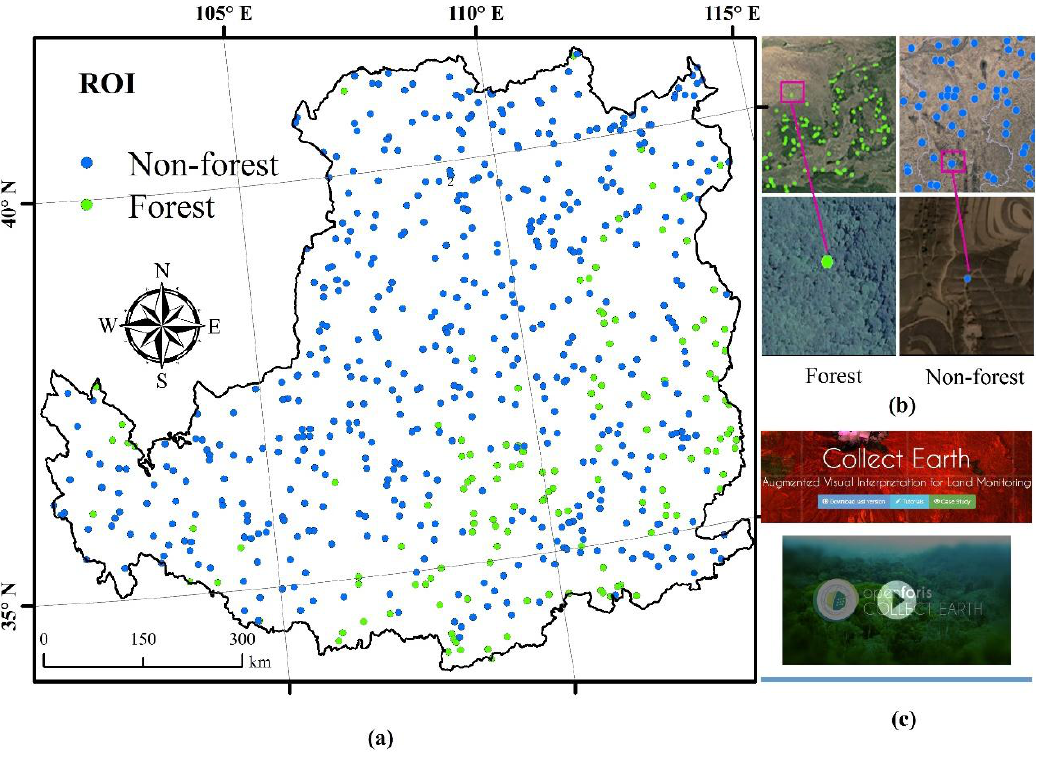
Figure 5. Spatial distribution of the randomly generated validation Regions of Interest (ROIs) in ArcGIS ( a ). Ground truth samples derived from Google Earth. Two ROIs include the forest region and non-forest region from the very high resolution (VHR) images of Google Earth from around 2010 ( b ). Using the Collect Earth software to verify the results of ROIs ( c ).